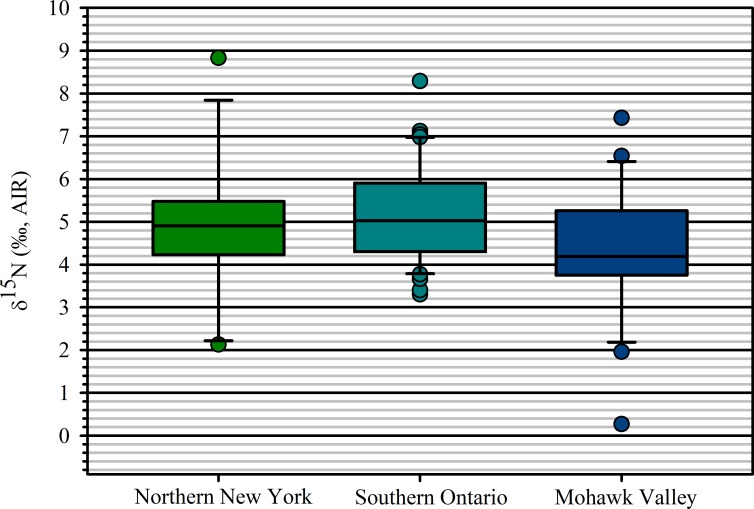
Box plots of δ15N values of archaeological maize from southern Ontario, northern New York, and the Mohawk Valley.The solid horizontal lines within the boxes are medians, boxes represent the 25th to 75th percentile and whiskers indicate 10th and 90th percentiles.